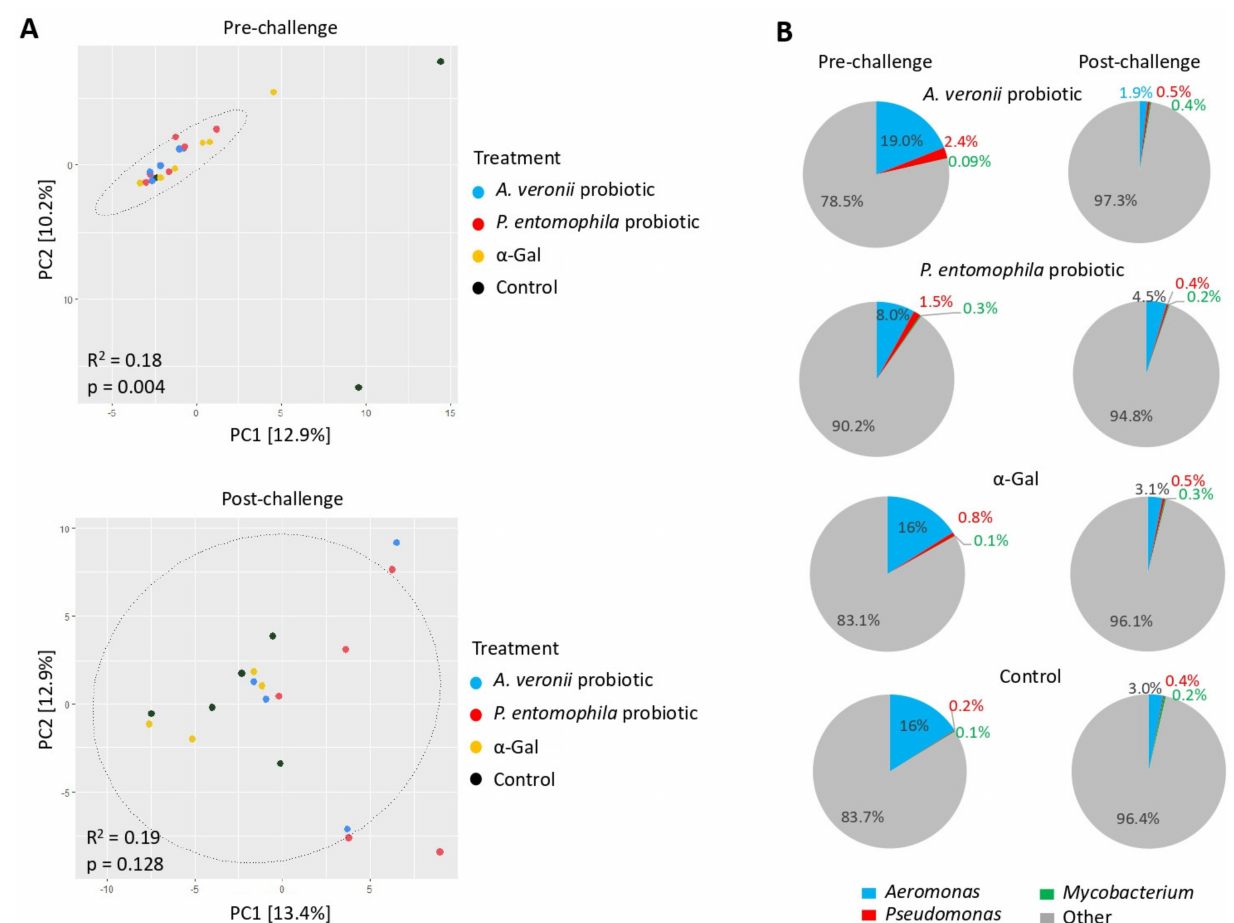
Figure 7. Zebrafish gut microbiota composition in response to probiotic and α -Gal treatments. ( A ) Principal component analysis of zebrafish gut microbiota grouped by treatment at pre-challenge and post-challenge stages. PCA ordination is based on the Bray–Curtis dissimilarity calculated with randomly rarefied data with no replacement applied to the centered- log transformed clr counts. The percentage of variation is explained by the principal components in the axis, PC1 and PC2. Ellipses indicate 95% confidence intervals. Each point represents one sample, and colors represent treatments/control groups. The closer the points are to one another, the more similar the microbiome composition of the samples are and vice versa. Adonis function in R software was used for PERMANOVA test to evaluate differences between groups. ( B ) Pie charts display the relative abundance of the genera Aeromonas , Pseudomonas , Mycobacterium and other found on each treatment group at pre-challenge and post-challenge stages. Relative abundance (%) of each genus was calculated from the ASVs raw counts obtained with DADA2 and normalized by total sum